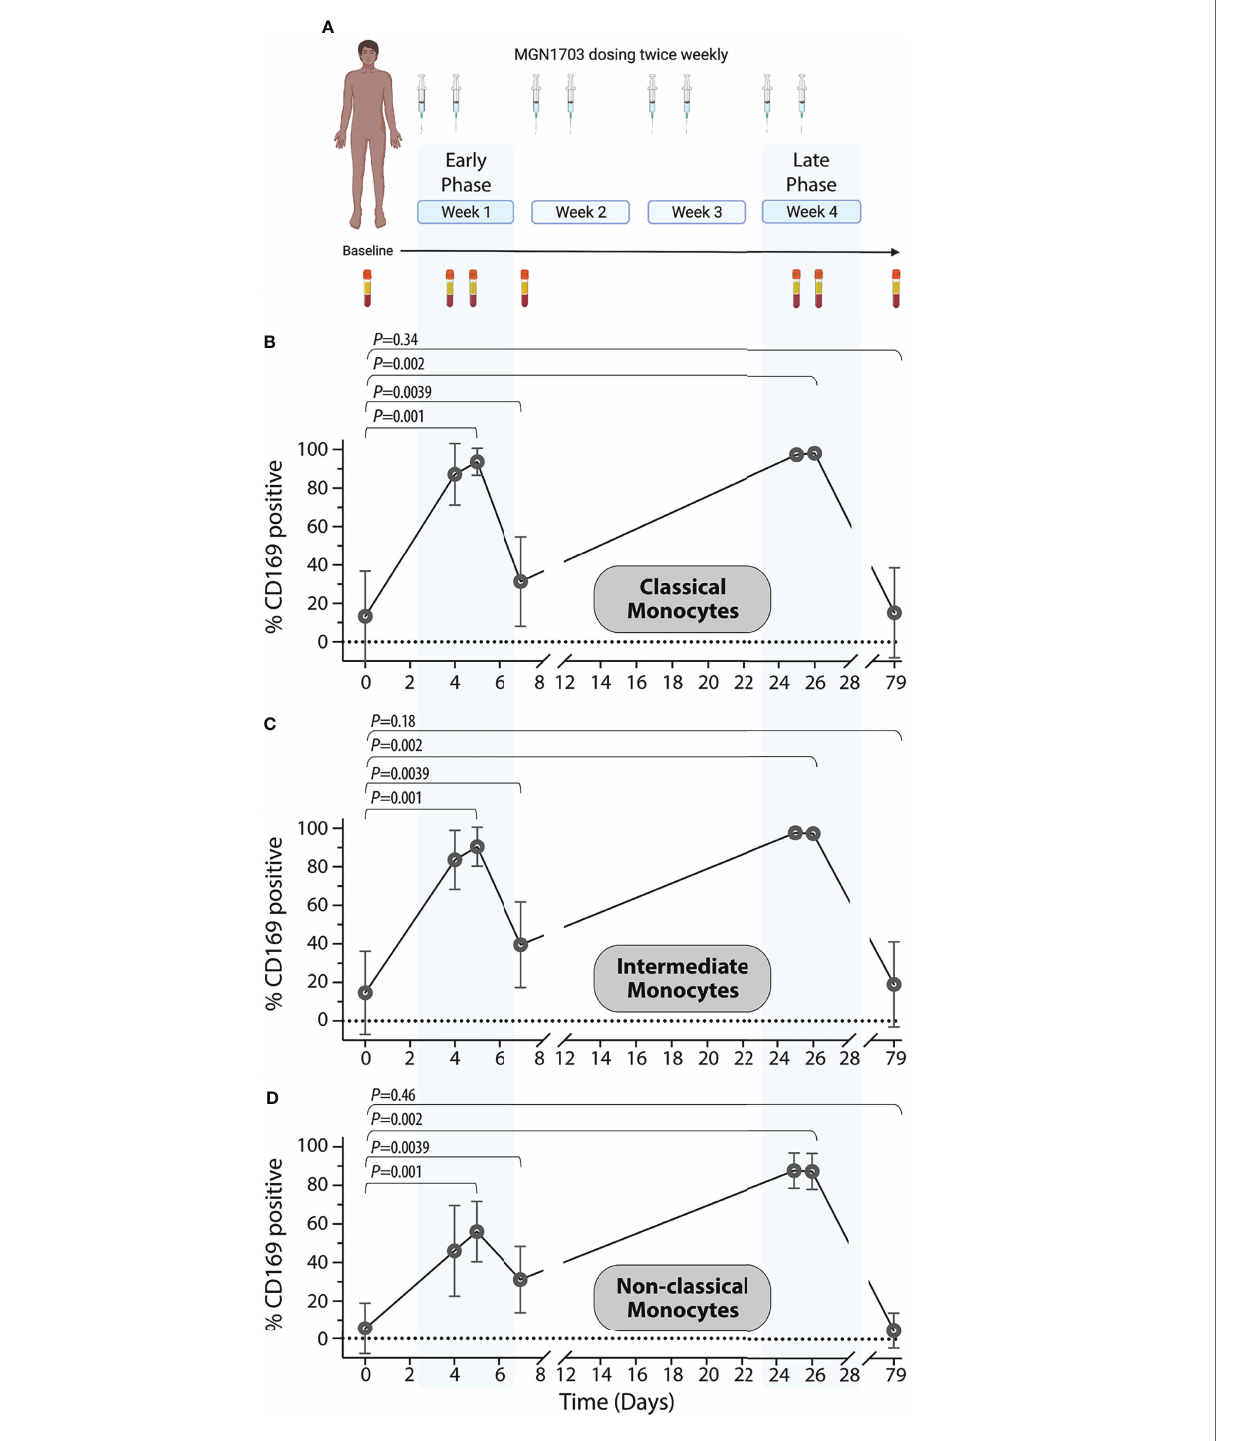
FIGURE 3 | In vivo upregulation of CD169 on human monocytes in a clinical TLR9 agonist study. (A) Schematic layout of a clinical Phase I/IIa trial (clinicaltrials.gov NCT02443935) investigating the immune-enhancing effects of TLR9 agonist (MGN1703) in HIV-infected individuals. Graphic created with Biorender. (B – D) Percentages of classical monocyte (B) , intermediate monocytes (C) , and non-classical monocytes (D) expressing CD169 are shown depicted with symbol and lines for averages (+/- SEM). Blue shaded areas indicate “ early ” and “ late ” dosing windows (dose 1 + 2 in the fi rst dosing week and dose 7 + 8 in the last dosing week). The following Wilcoxon sign-ranked test statistical comparisons were made for each monocyte population: baseline vs. day 5 (Peak 1); baseline vs. day 7 (Trough); baseline vs. day 26 (Peak 2); and baseline vs. day 79